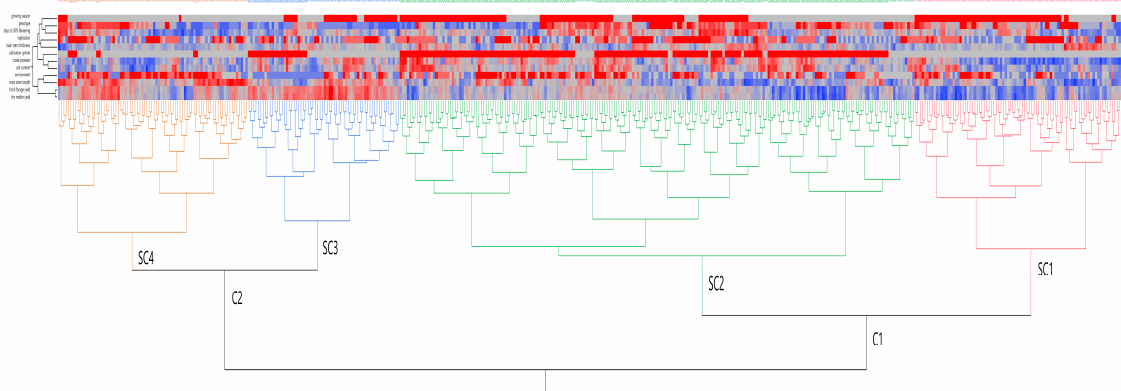
Figure 8. Dendrogram of two-way clustering based on the variables measured in peas using Ward’s method on the standardized data to define distances between clusters. Blue areas in the map dendrogram indicate low values, whereas the red areas indicate high values.